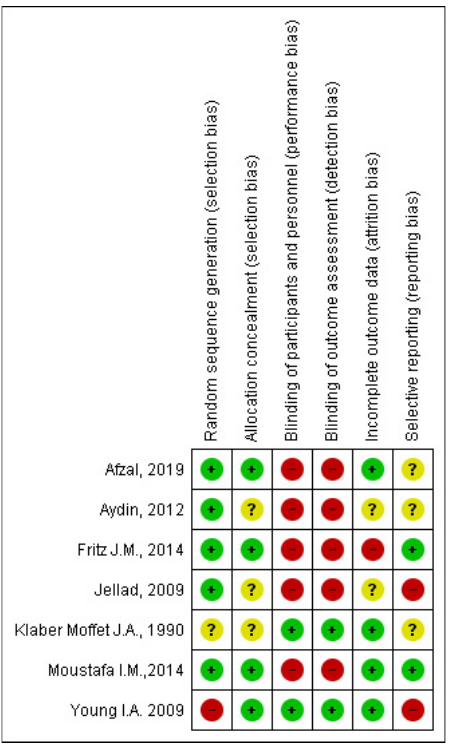
Figure 2. Risk of bias graph. Legend: Red (-) = high risk of bias; Yellow (?) = unknown risk of bias; Green (+) = low risk of bias.